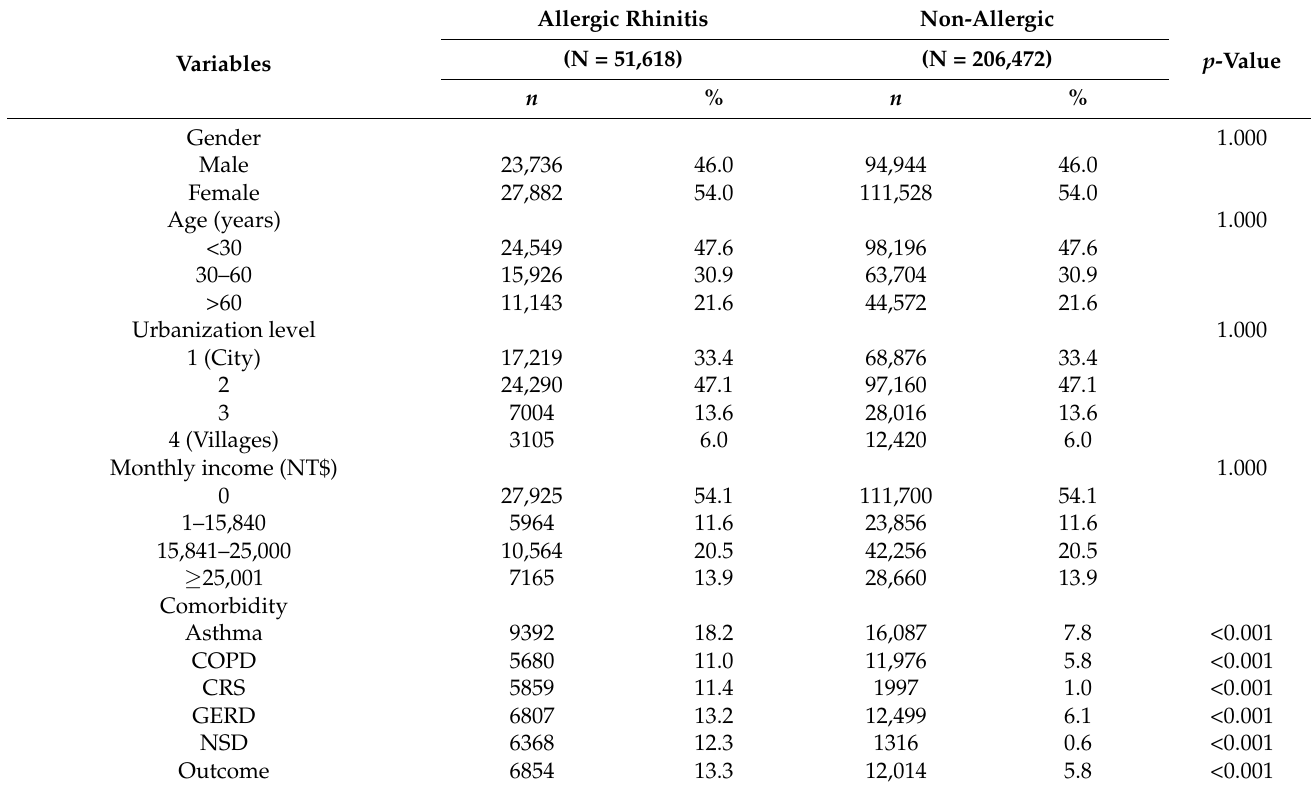
Table 1. Study participants’ baseline